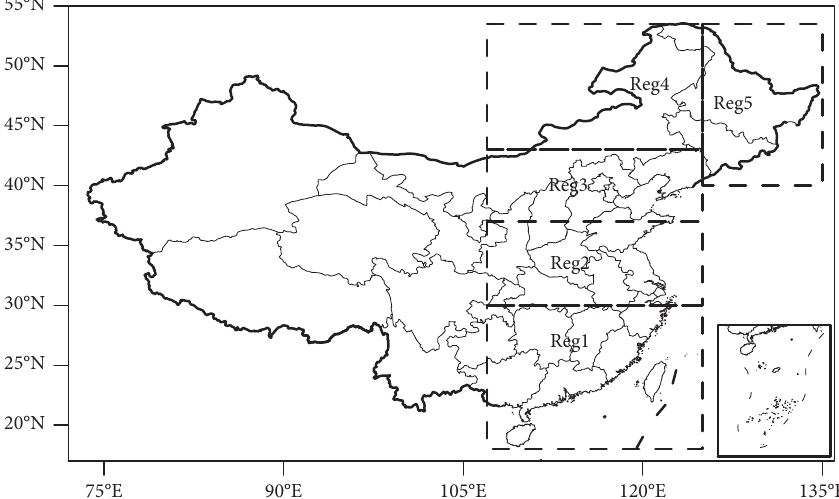
Figure 2: The region east of 107 ° E in China is divided into five subregions which are denoted by the black dashed rectangles. The lower right part of the figure is an administrative zoning map of the South China